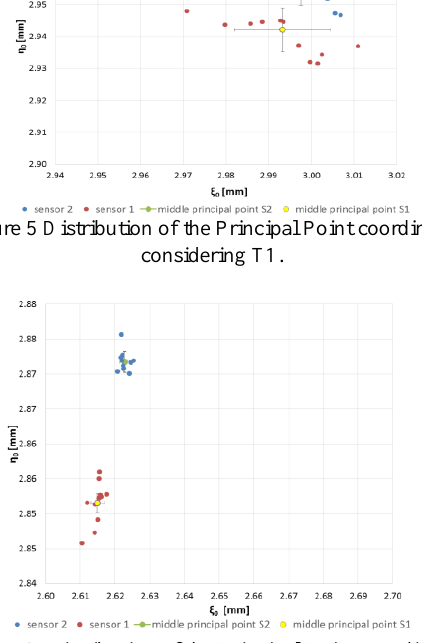
Figure 6. Distribution of the Principal Point coordinates considering T2.